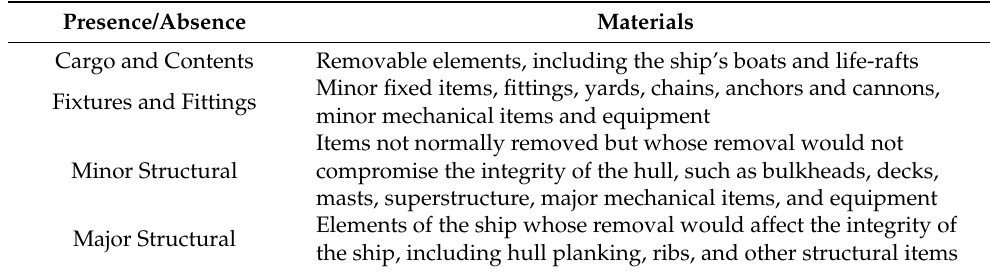
Table 2. Categories constituting a shipwreck, adapted from Gibbs [36].